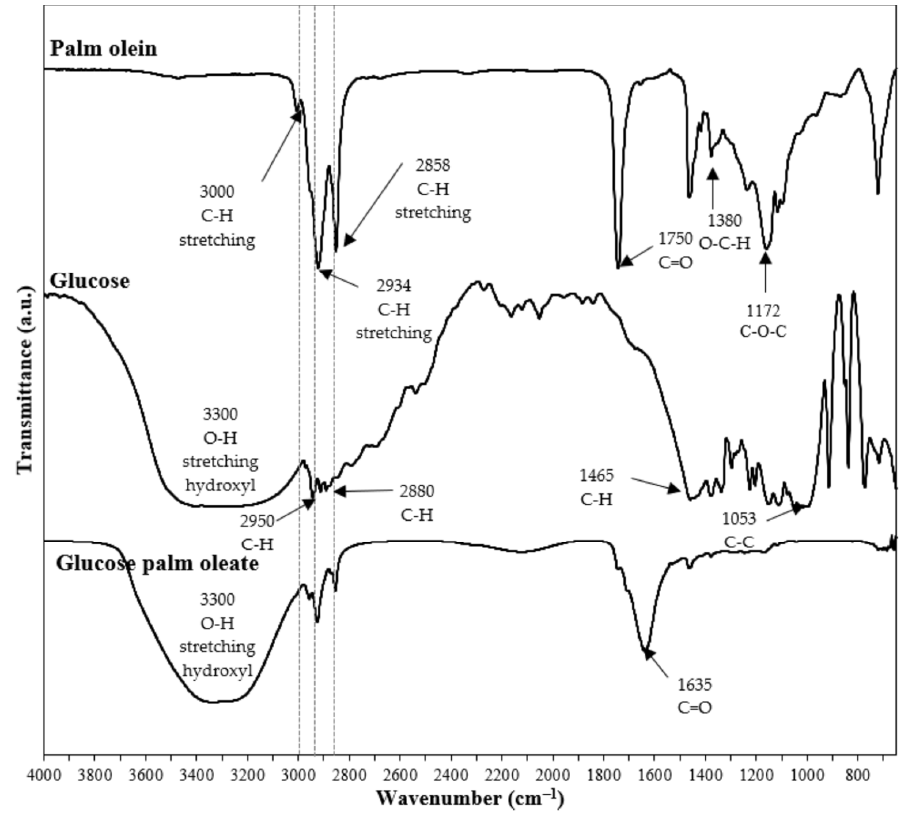
Figure 4. FTIR spectrums of palm olein, glucose, and glucose palm oleate product.